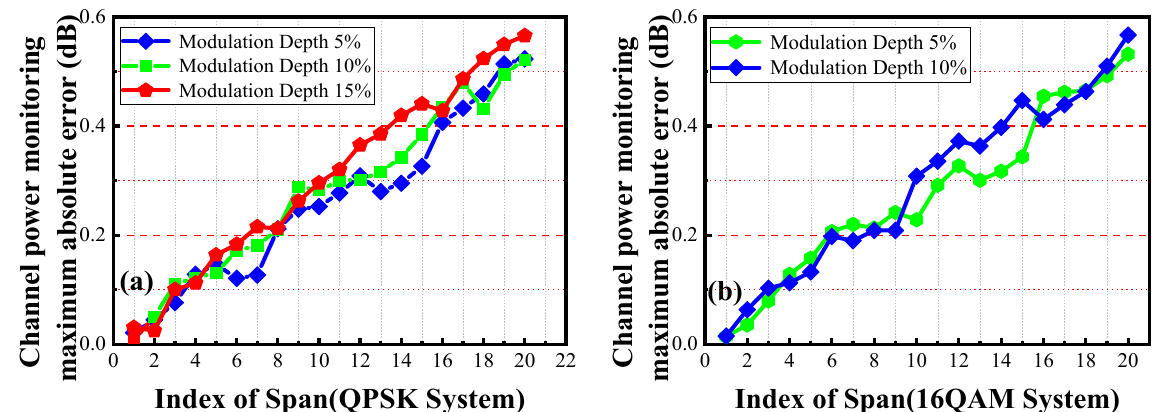
Figure 5. The optical power monitoring results of ( a ) 8-channel QPSK, ( b ) 8-channel 16QAM system. In addition, taking a QPSK system as an example, the impact of channel number on the accuracy of channel power monitoring is also investigated. Here, the optical label modulation depth is fixed to 0.10, while the number of monitoring channels is set from 5 to 64. The monitoring error of channel optical power of different wavelength channel numbers after 20-span transmission is shown in Figure 6.